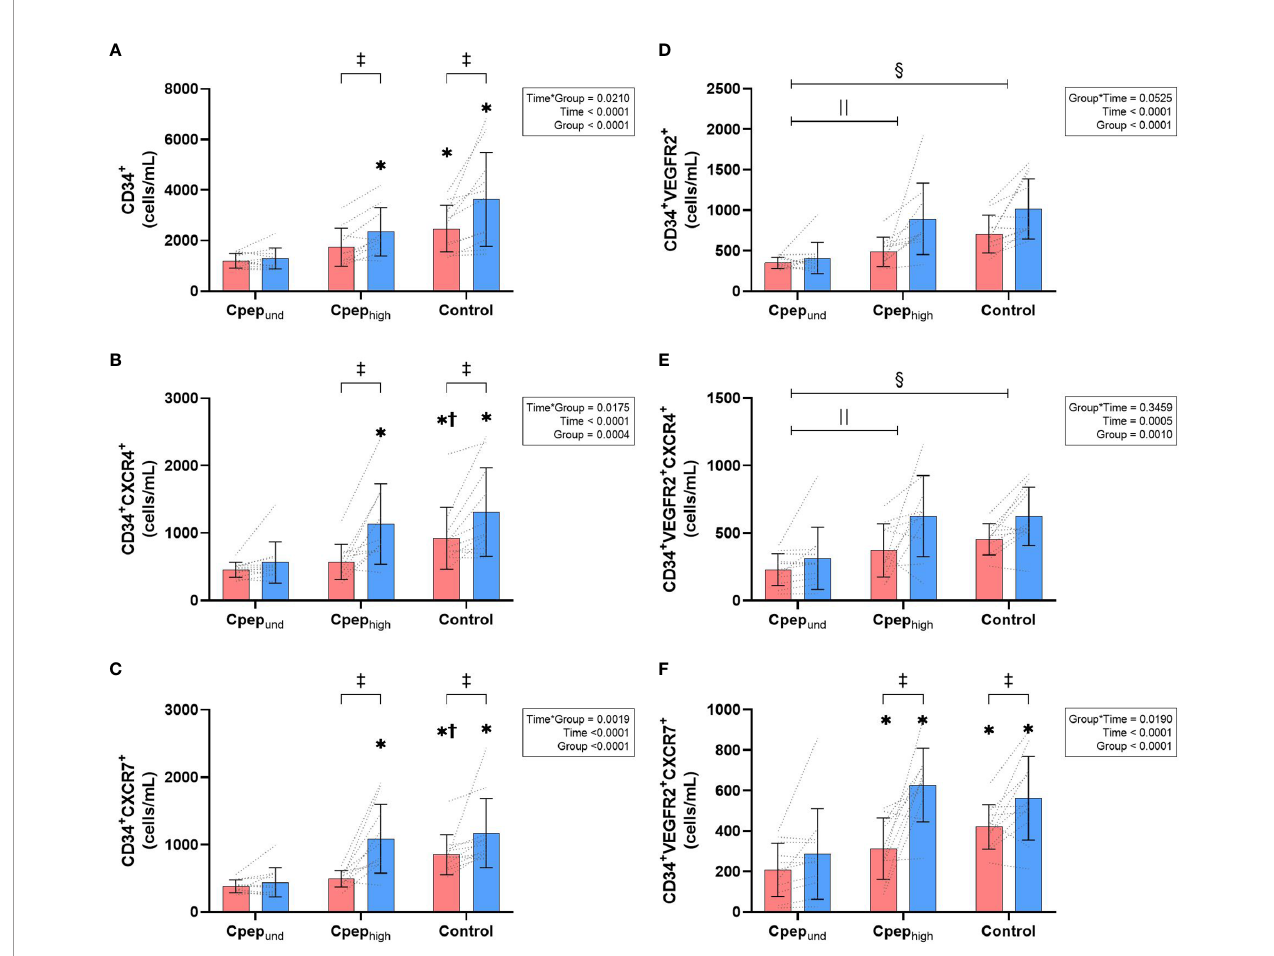
FIGURE 1 | Mean (± SD) group and individual time course changes from rest (red bars) to immediately post-exercise (blue bar) for absolute count (cells/mL) of CD34 + HPCs (A) , CD34 + HPCs expressing CXCR4 + (B) , and CD34 + HPCs expressing CXCR7 + (C) , as well as CD34 + VEGFR2 + EPCs (D) , CD34 + VEGFR2 + EPCs expressing CXCR4 + (E) , and CD34 + VEGFR2 + EPCs HPCs expressing CXCR7 + (F) . Data were analysed by a two-way mixed-model ANOVA. Where a statistically signi fi cant interaction effect exists - * represents a signi fi cant differences compared to Cpep und at that timepoint, † represents a signi fi cant differences compared to Cpep high at that timepoint, ‡ represents a signi fi cant differences from rest to immediately post-exercise. Where a statistically signi fi cant interaction effect did not exists, || represents a signi fi cant group differences between Cpep und and Cpep high , § represents a signi fi cant group differences between Cpep und and non-diabetes